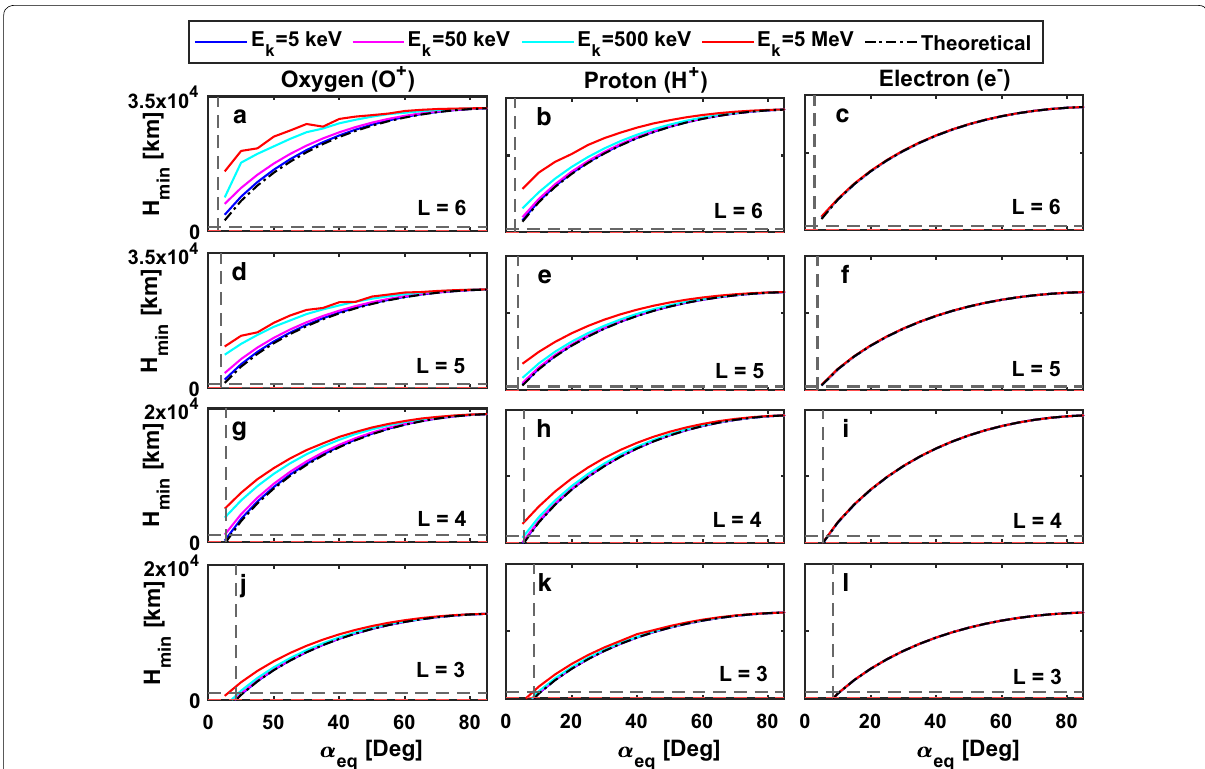
Fig. 8 The minimum vertical height, H min of oxygen ions ( a , d , g , j ), protons ( b , e , h , k ) and electrons ( c , f , i , l ) above the surface of the Earth as a function of equatorial pitch angle. Here, H min = r min − R e . Each subplot is obtained for the fixed L-shell and four different values of energy. The dashed-dotted black and solid lines represent the theoretical and simulation results, respectively. The vertical dashed line corresponds to the loss cone angle, and the horizontal dashed line represents the upper ionospheric boundary at 1000 km. H min = 0 indicates the surface of the Earth